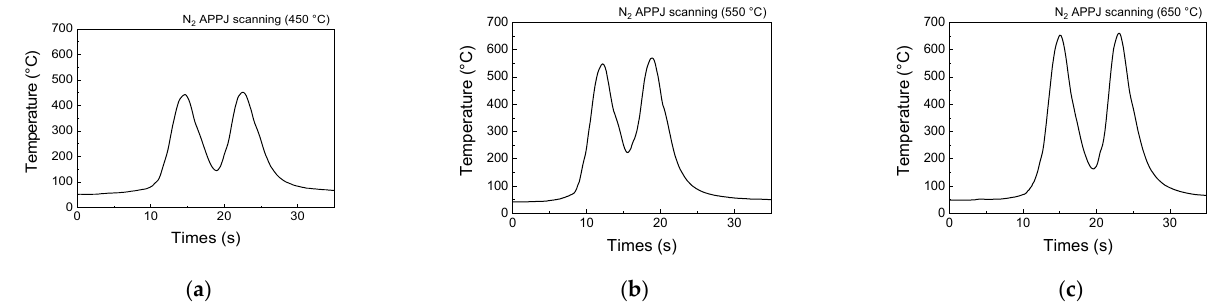
Figure 2. Temperature–time courses of GFs during APPJ treatments for nitrogen flow rates of ( a ) 56, ( b ) 40, and ( c ) 30 SLPM.